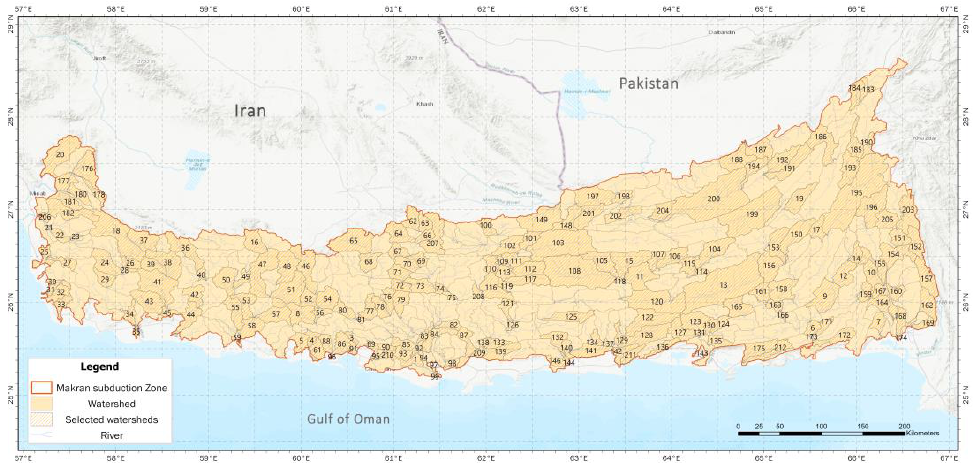
Figure 1. Location of Makran subduction zone and border of 423 extracted watersheds. The number labels show the randomly selected watershed used in AI.